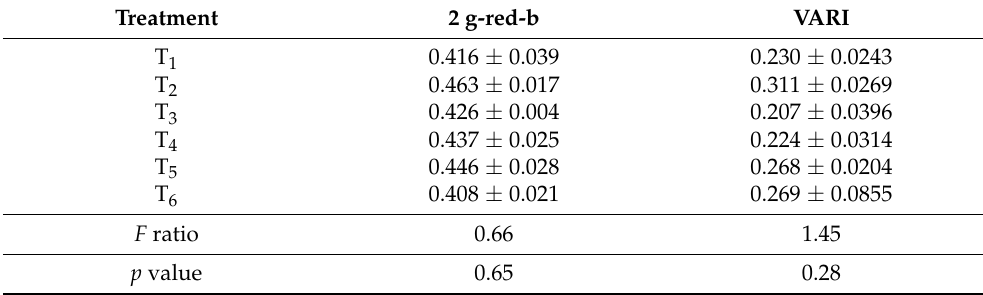
Table 4. Canopy coverage and architecture analysis using camara-based vegetative indices (2g-red-b